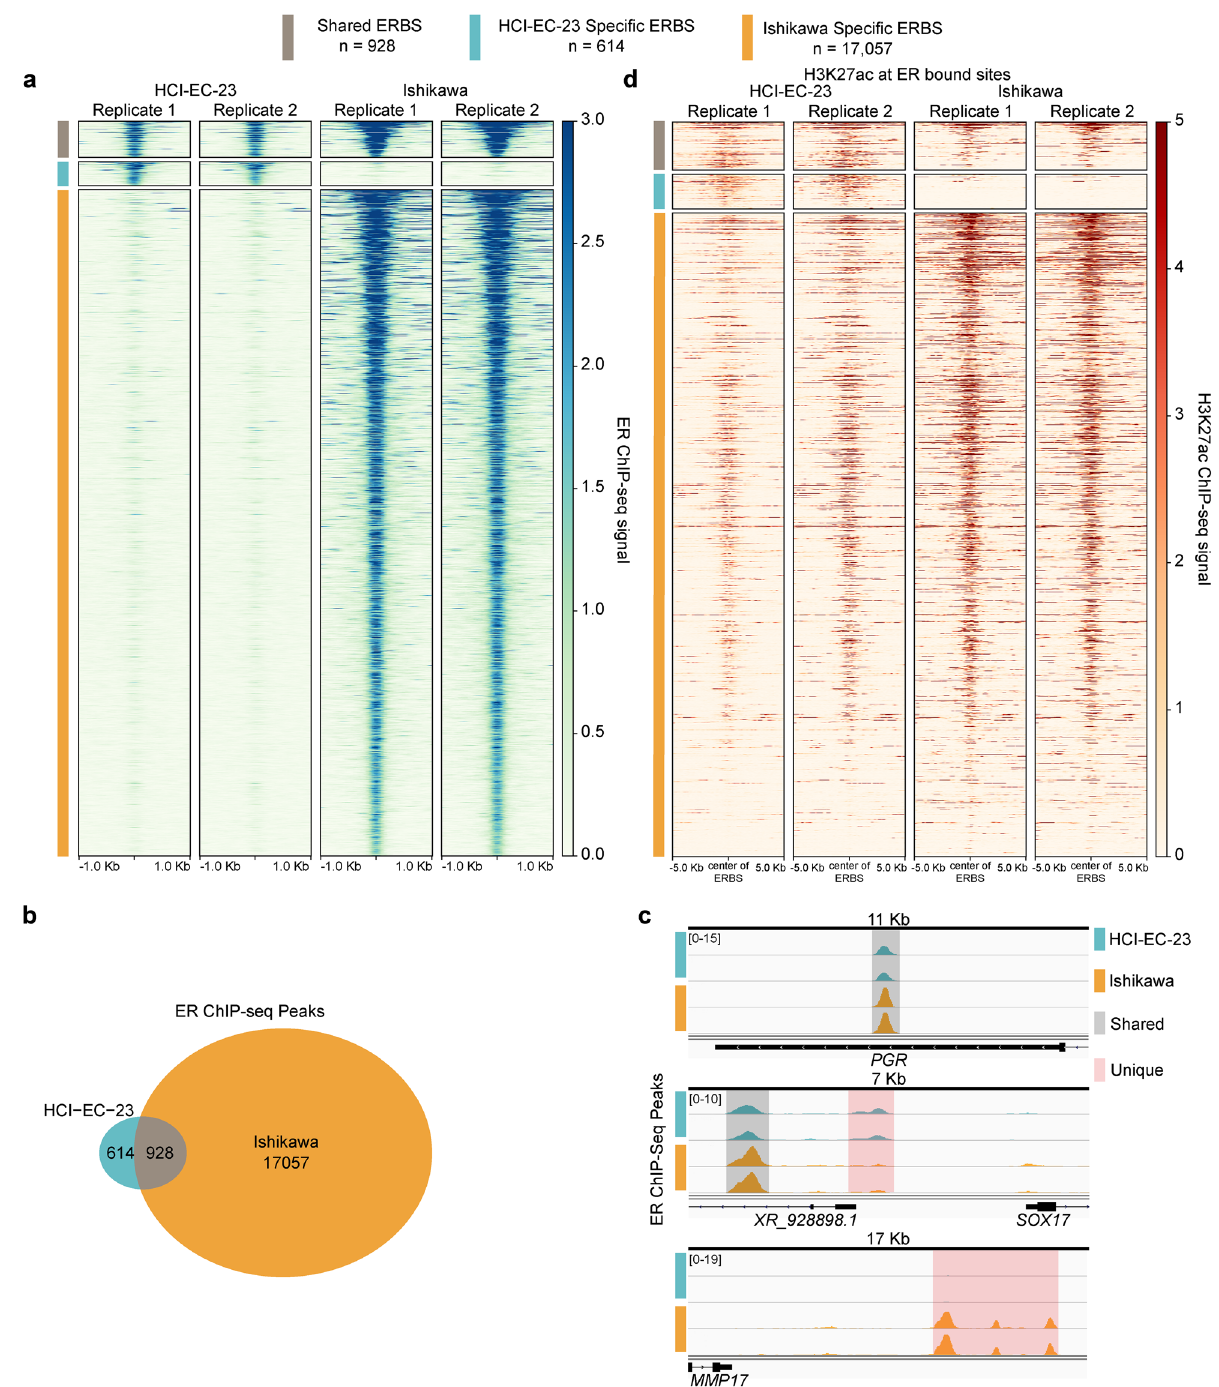
Figure 5. ER genomic binding in HCI-EC-23 is similar but distinct to Ishikawa. (a) A heatmap is shown for ER genomic binding signal. Each row represents a ChIP-seq peak and is annotated by estrogen receptor bound site (ERBS) category—either shared ERBS, HCI-EC-23 specific ERBS, or Ishikawa specific ERBS according to the legend above the heatmap. Each column is a sample (two replicates per cell line). (b) A Venn diagram shows the overlap between ER ChIP-seq peaks in HCI-EC-23 and Ishikawa cell lines. (c) Genome browser tracks plotting ER ChIP-seq peaks are shown for HCI-EC-23 and Ishikawa. Regions shown are the 3’ UTR of PGR , the region upstream of SOX17 , and the region downstream of MMP17 . Shared peaks between the two cell lines are highlighted in gray, while unique peaks are highlighted in red. Peak height is scaled within each locus. (d) A heatmap shows the H3K27ac signal without E2 treatment at ER bound sites. Each row represents H3K27ac signal centered around an identified ERBS (and is ordered as in a ). The different categories of ERBS are annotated (as in a ) according to the legend above the heatmap. Each column is a sample (two replicates per cell